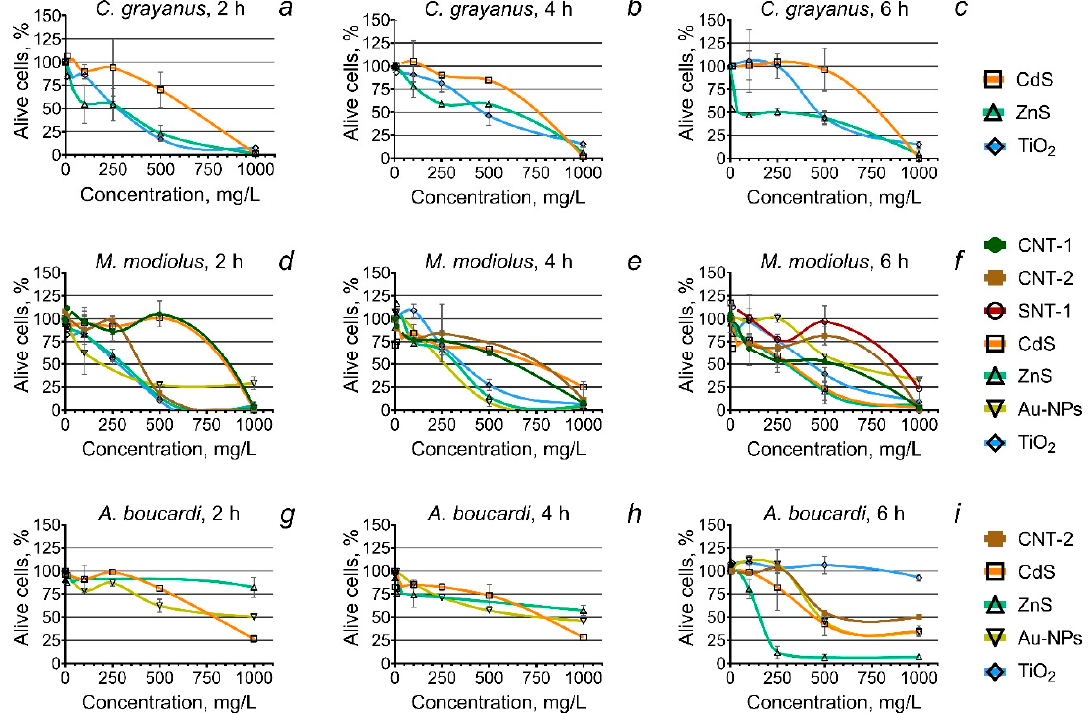
Figure 1. The viability of hemocyte cells of the molluscs C. grayanus , M. modiolus , and A. boucardi after the treatment with the nanoparticles (NPs); ( a – c ) the changes in the total number of alive C. grayanus hemocytes after 2, 4, and 6 h exposure to the NPs, respectively; ( d – f ) the changes in the total number of alive M. modiolus hemocytes after 2, 4, and 6 h exposure to the NPs, respectively; and ( g – i ) the changes in the total number of alive A. boucardi hemocytes after 2, 4, and 6 h exposure to the NPs, respectively. CNT, carbon nanotube; SNT, silicon nanotube.